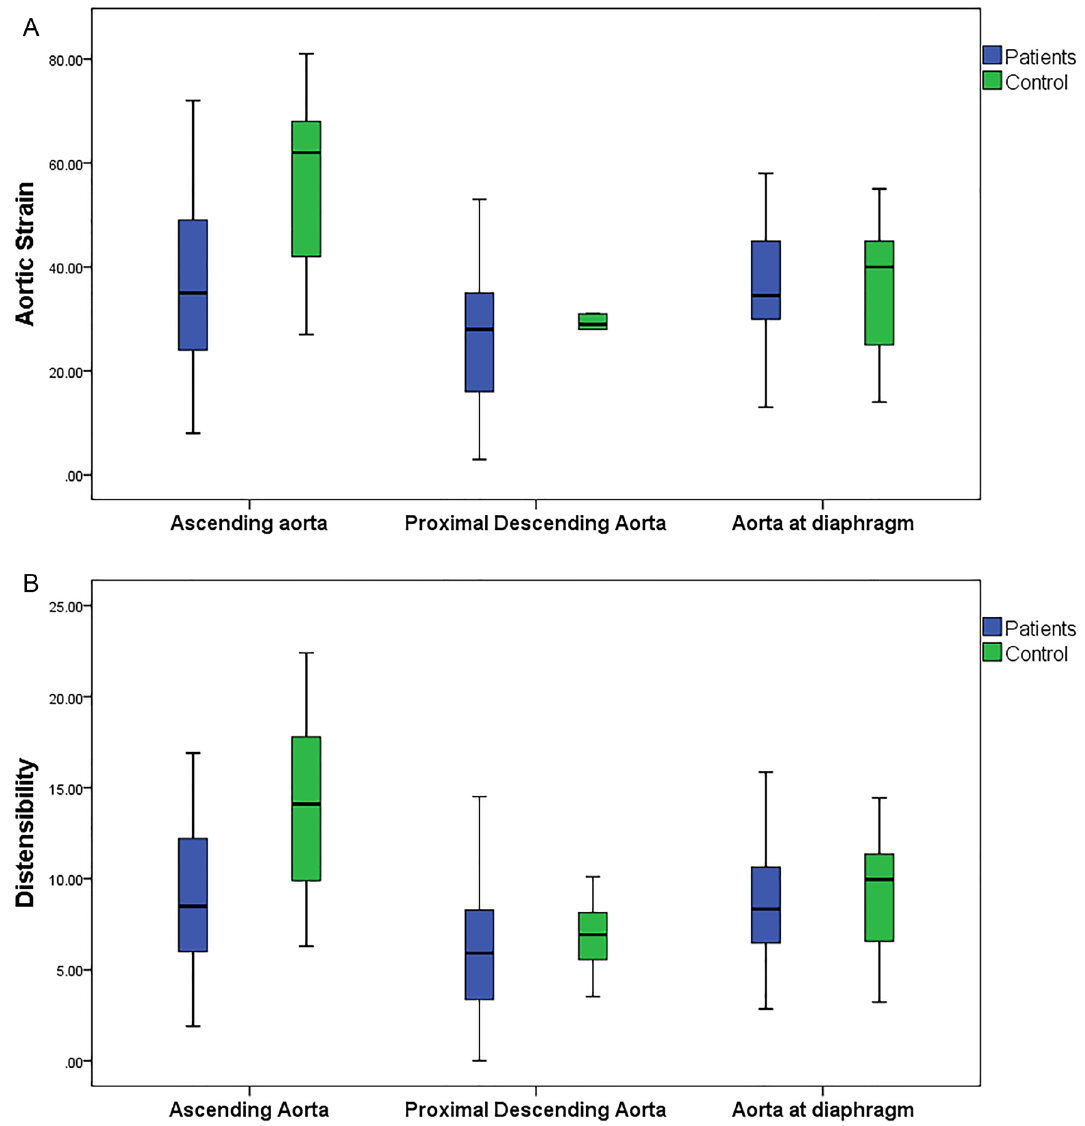
Figure 2. Box plots of aortic strain (A) and aortic distensibility (B) represent the difference between patients and control group at ascending aorta, proximal descending aorta and aorta at